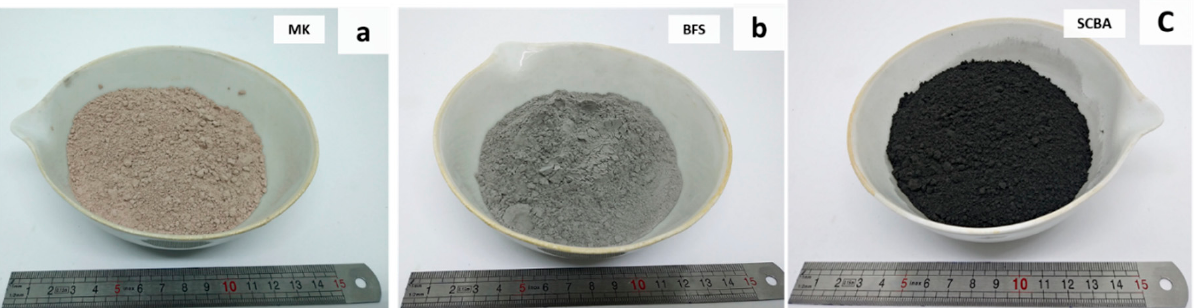
Figure 9. Visual analysis of ( a ) MK, ( b ) BFS and ( c ) SCBA.